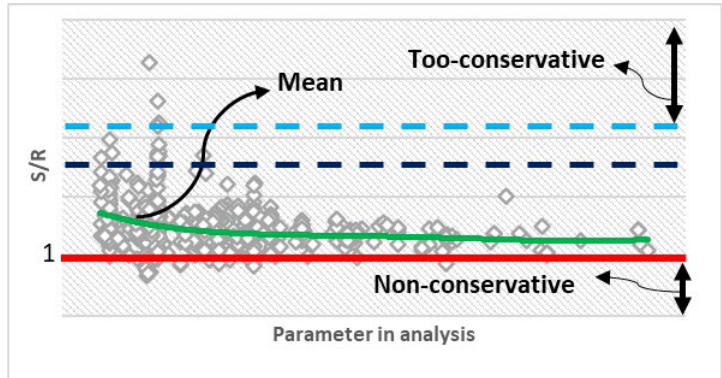
Figure 2- Dispersion points of